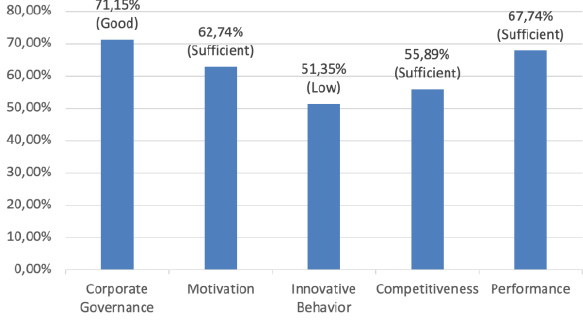
Figure 2: Descriptive Analysis Total